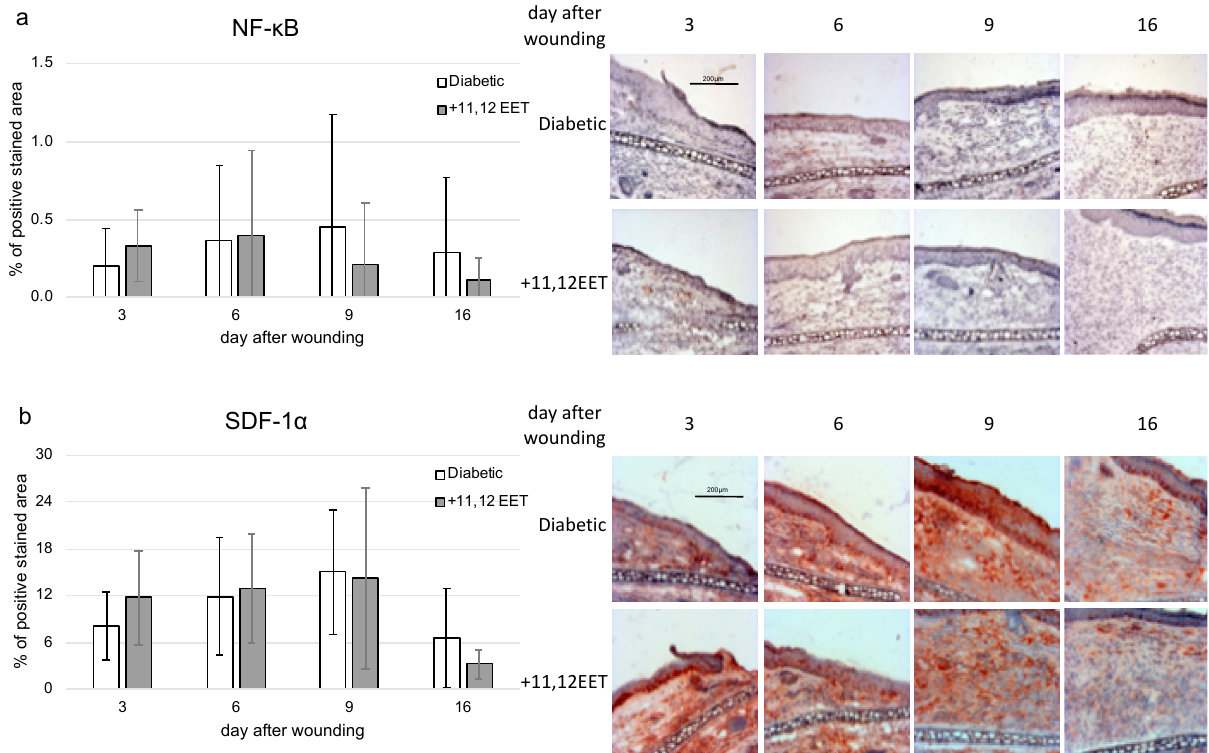
Figure 4. ( a ) Percentage of NF- κ B-positive area on days 3, 6, 9, and 16 after wounding of diabetic mice without and after treatment with 11,12 EET; on the right, representative pictures of the staining ( n = 10 ). ( b ) Percentage of SDF-1 α -positive cells on days 3, 6, 9, and 16 after wounding of diabetic mice without and after treatment with 11,12 EET; on the right, representative pictures of the staining ( n = 12 ). (Data are shown as mean ± SD).